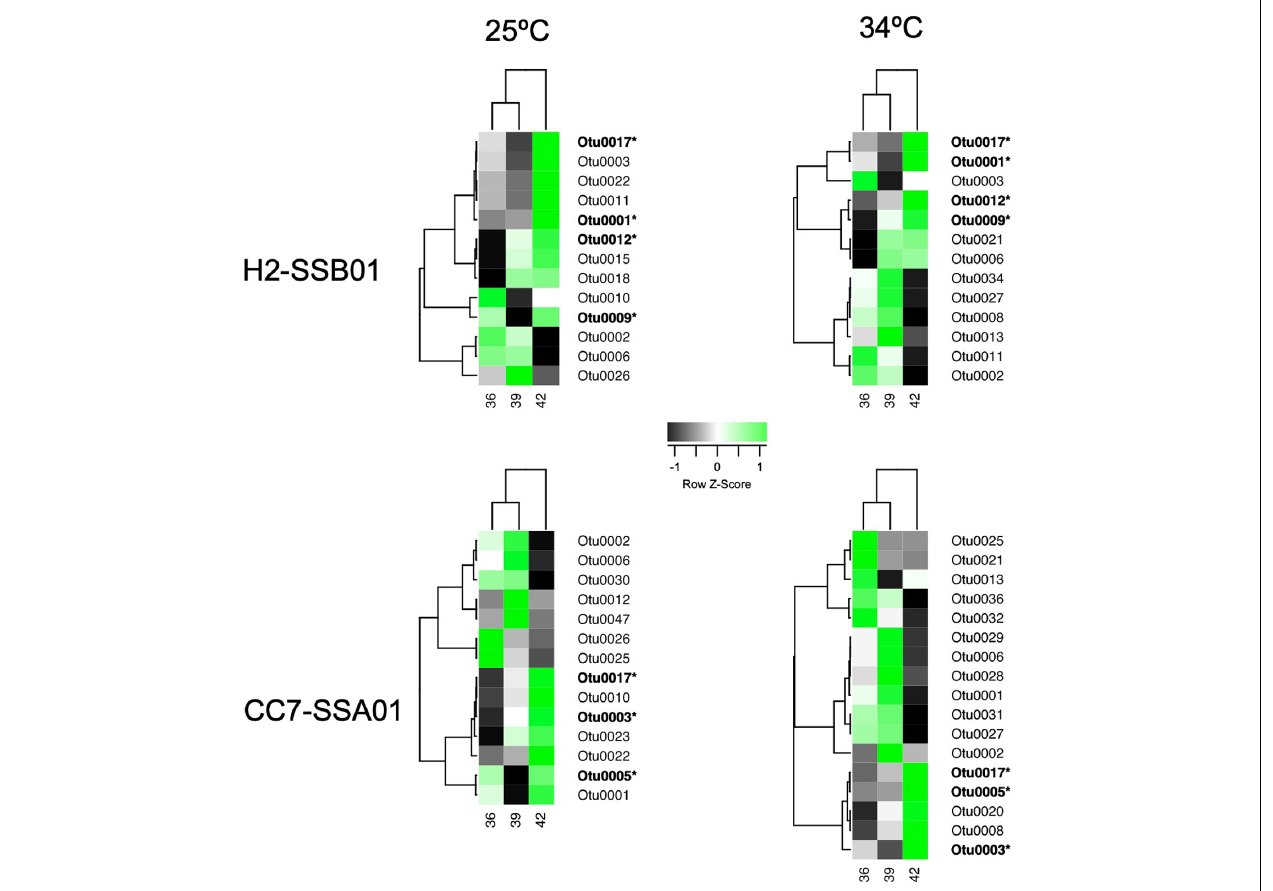
FIGURE 3 | Heat map displaying differentially abundant bacterial taxa across salinities (36 PSU, 39 PSU, and 42 PSU) under ambient temperature (25 ◦ C) and heat stress (34 ◦ C) for Aiptasia host-algal symbiont pairings H2-SSB01 and CC7-SSA01 based on SIMPER analyses. Shown are bacterial taxa that contribute up to 50% of the cumulative differences between salinities. Color indicates Z -score normalized average abundance scaled by taxa. Taxa were clustered by similarity using Pearson correlation coefficient. OTUs in bold and with asterisk denote bacterial taxa that exhibited consistent relative high abundance at high